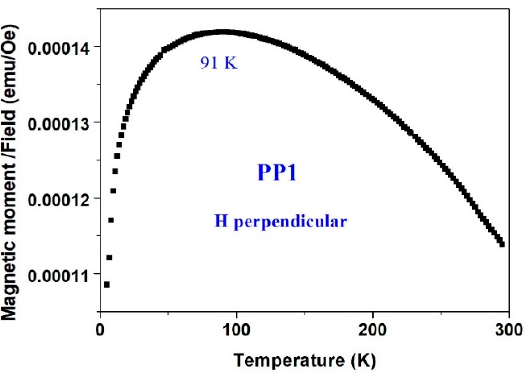
Figure 14. The temperature dependence of the susceptibility ( m / H ) under applied fields of 500 Oe measured parallel and perpendicular of PP1 sample.